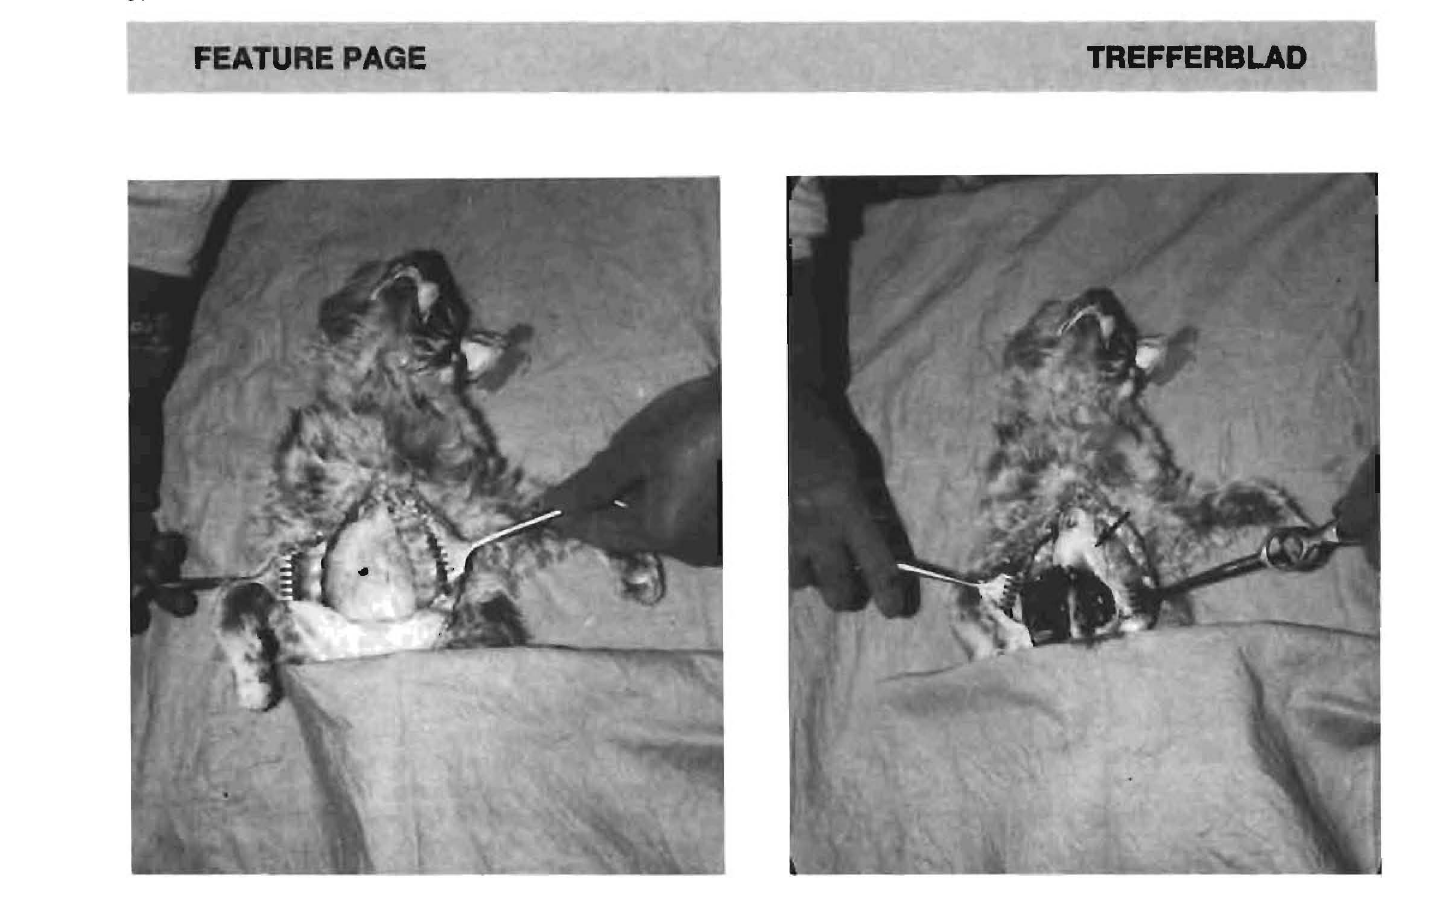
Fig. 1 toon 'n post mortem ondersoek op 'n 5 maande oue wyfiekatjie waarvan die toraks oopgerek word.